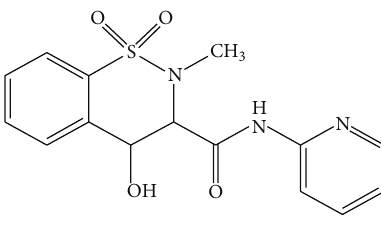
Figure 1: The chemical structure of